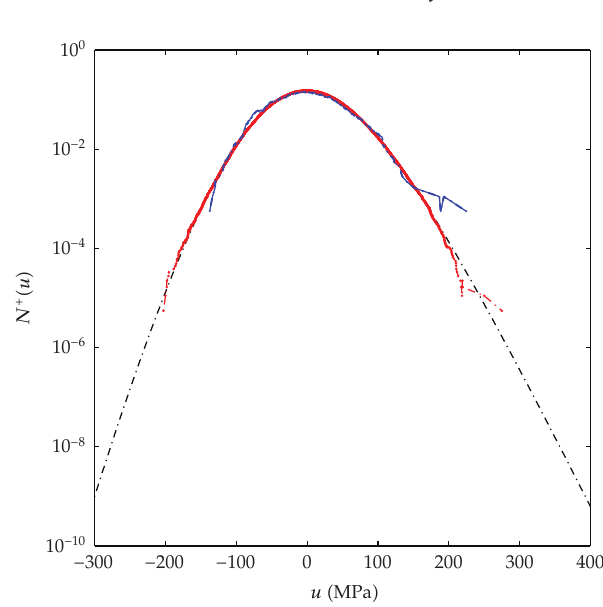
Figure 3: Example 5.1: Observed crossing intensity N (cid:2) u (cid:3) in the measured stress-solid line; simulated crossing intensity in 100 times longer signal than measured (cid:2) 50 hours (cid:3) —solid line with dots; the saddle- point approximation μ s (cid:2) u (cid:3) of E (cid:5) N (cid:2) u (cid:3)(cid:6) —dashed dotted